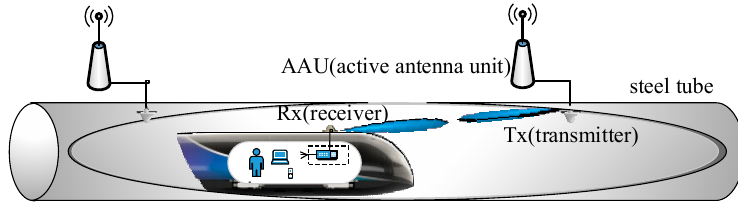
Figure 1. The sketch of the distributed antenna system.